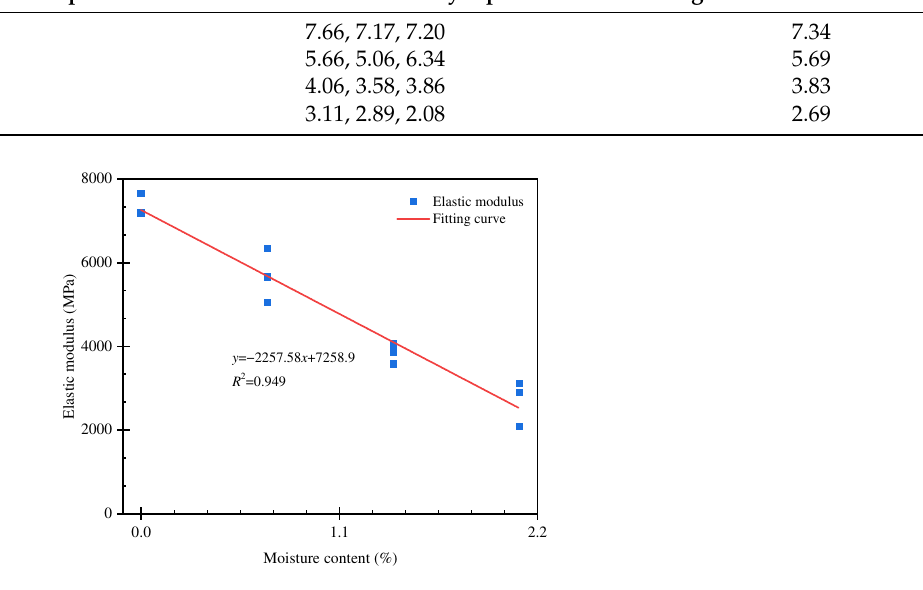
Figure 7. Fitting relationship of elastic modulus of muddy sandstone with different moisture con- tents.